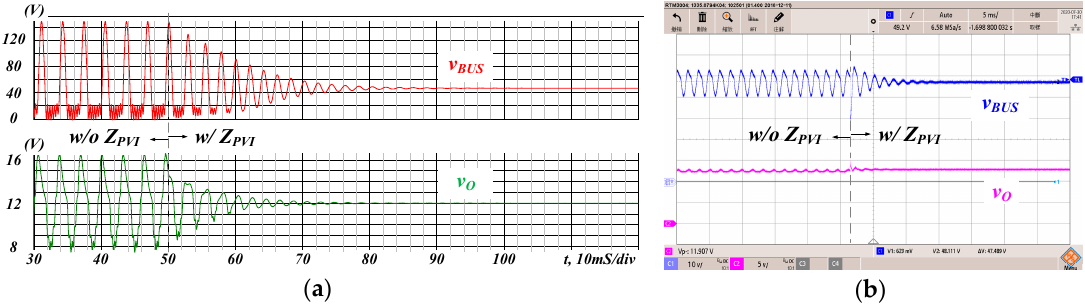
Figure 24. System waveform before and after adding virtual impedance ( a ) simulation results ( b ) measurement results (scale v BUS [Ch1]: 50V / div; i O [Ch2]: 5A / div; v O [Ch3]: 20 V / div; time: 1 ms / div). actual measurement results (scale v BUS [Ch1]: 50V/div; i O [Ch2]: 5A/div; v O [Ch3]: 20 V/div; time: 1 ms/div).